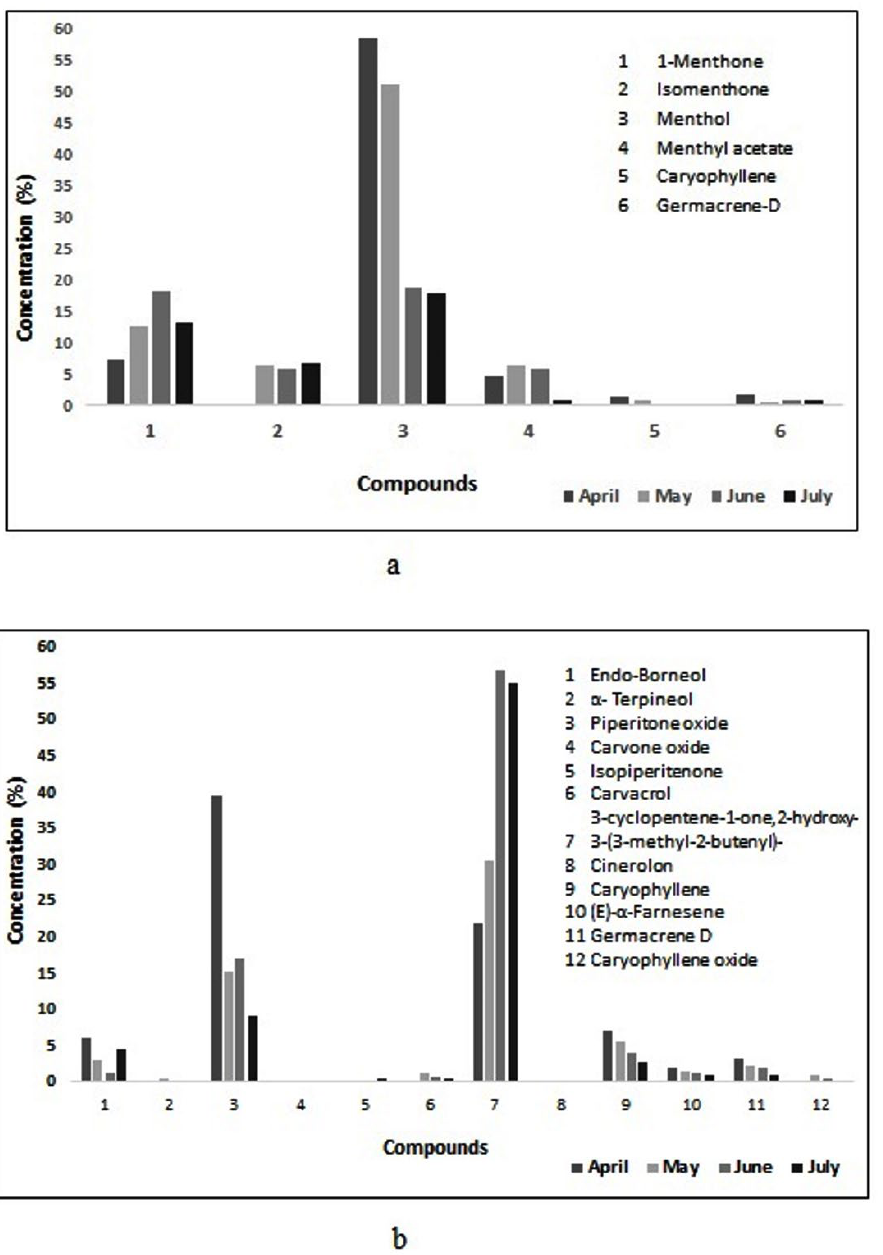
Fig. 3. Monthly variation in the composition of essential oil of the leaves of M. piperita (a) and M. longifolia